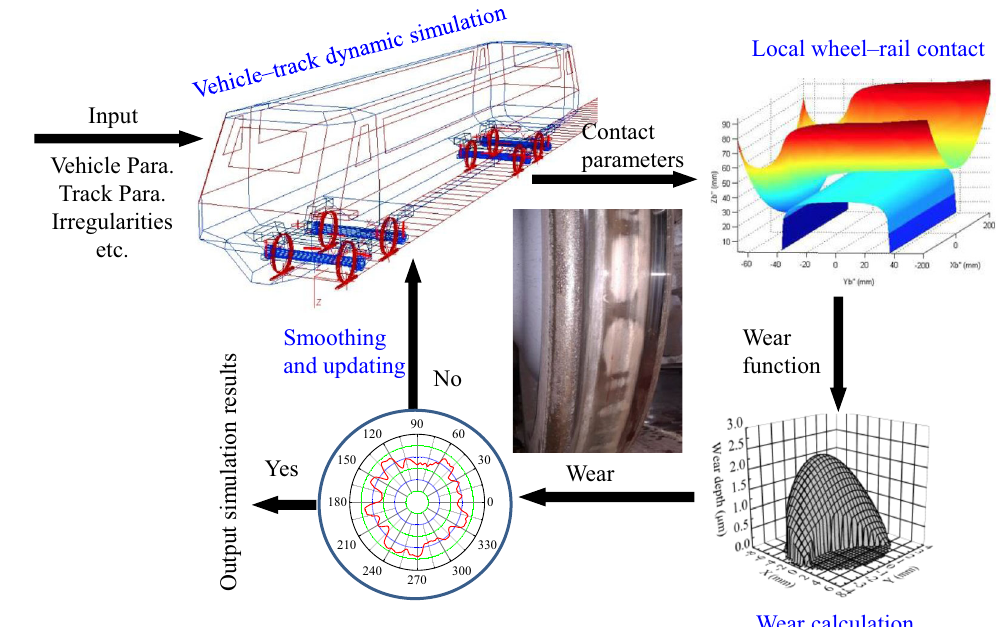
Fig. 19 General architecture of wheel polygonisation